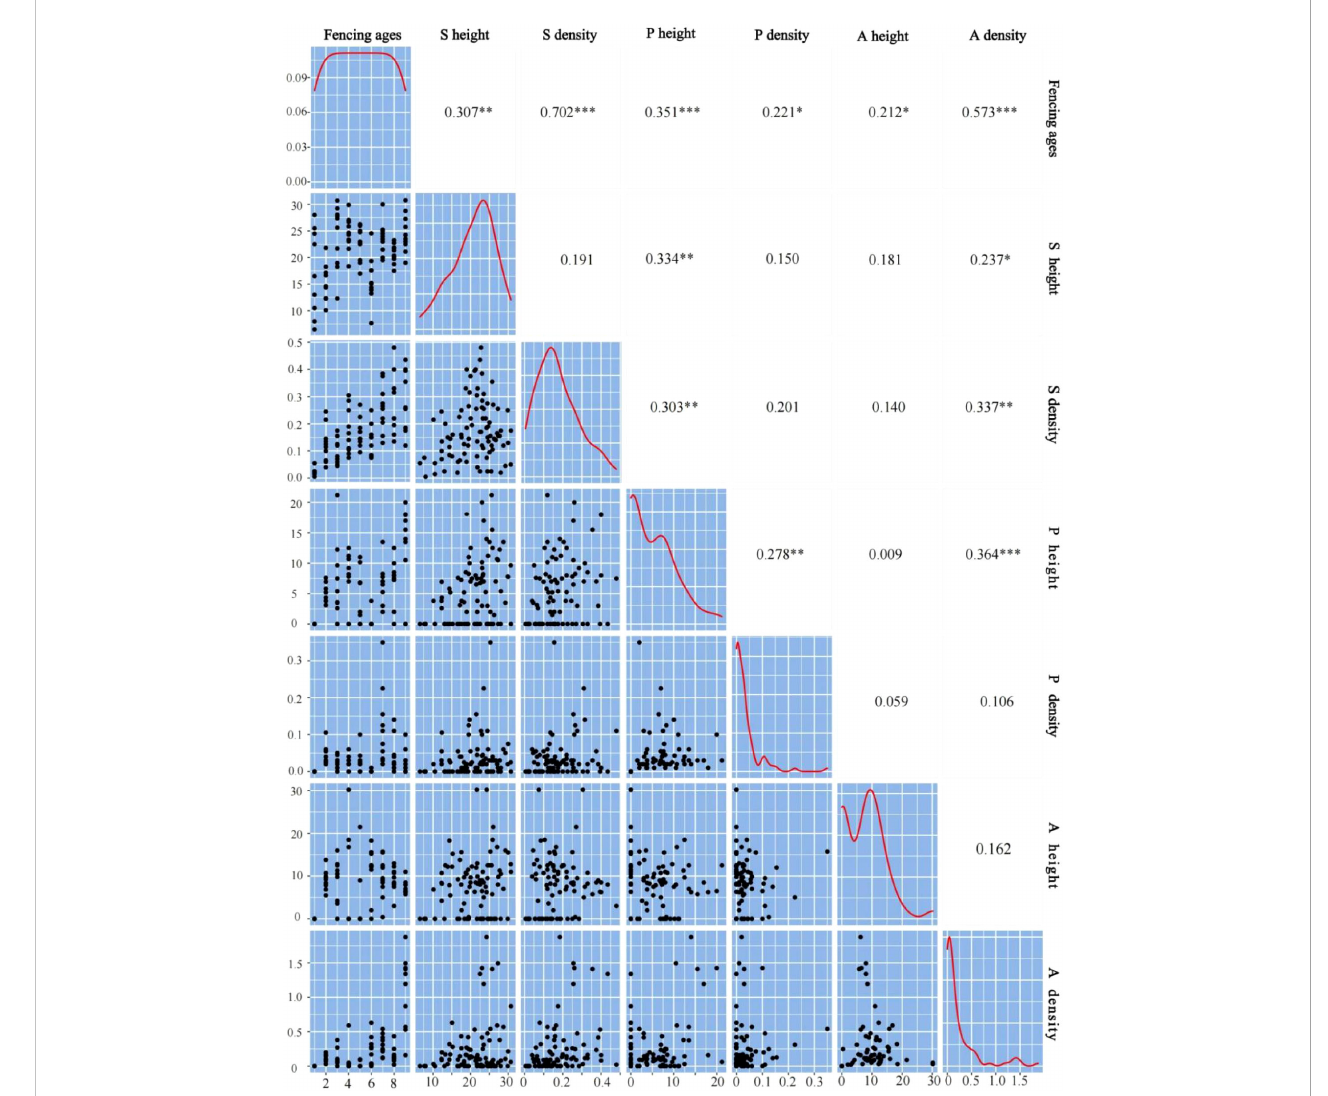
FIGURE 6 Correlation of biological indexes between shrub layer and herb layer. S height represent the shrub height; S density represent the shrub density; P height represent the perennial herb height; P density represent the perennial density; A height represent the annual herb height; A density represent the annual herb density. *p < 0.05; **p < 0.01; ***p <